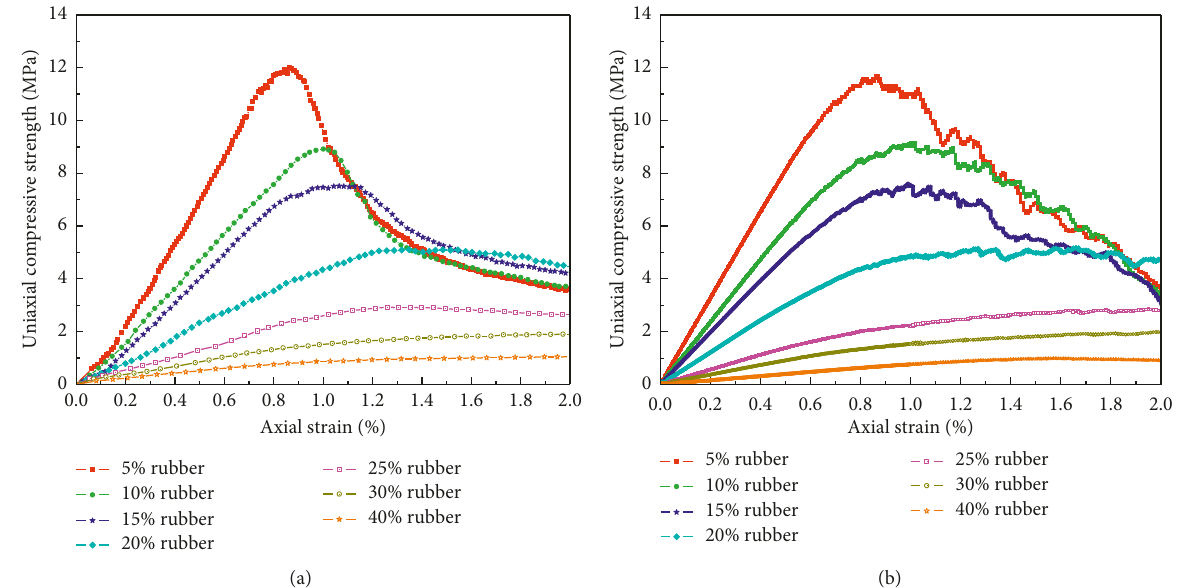
Figure 10: Comparison of constitutive curves obtained by laboratory experiments (a) and those obtained by numerical simulations (b).